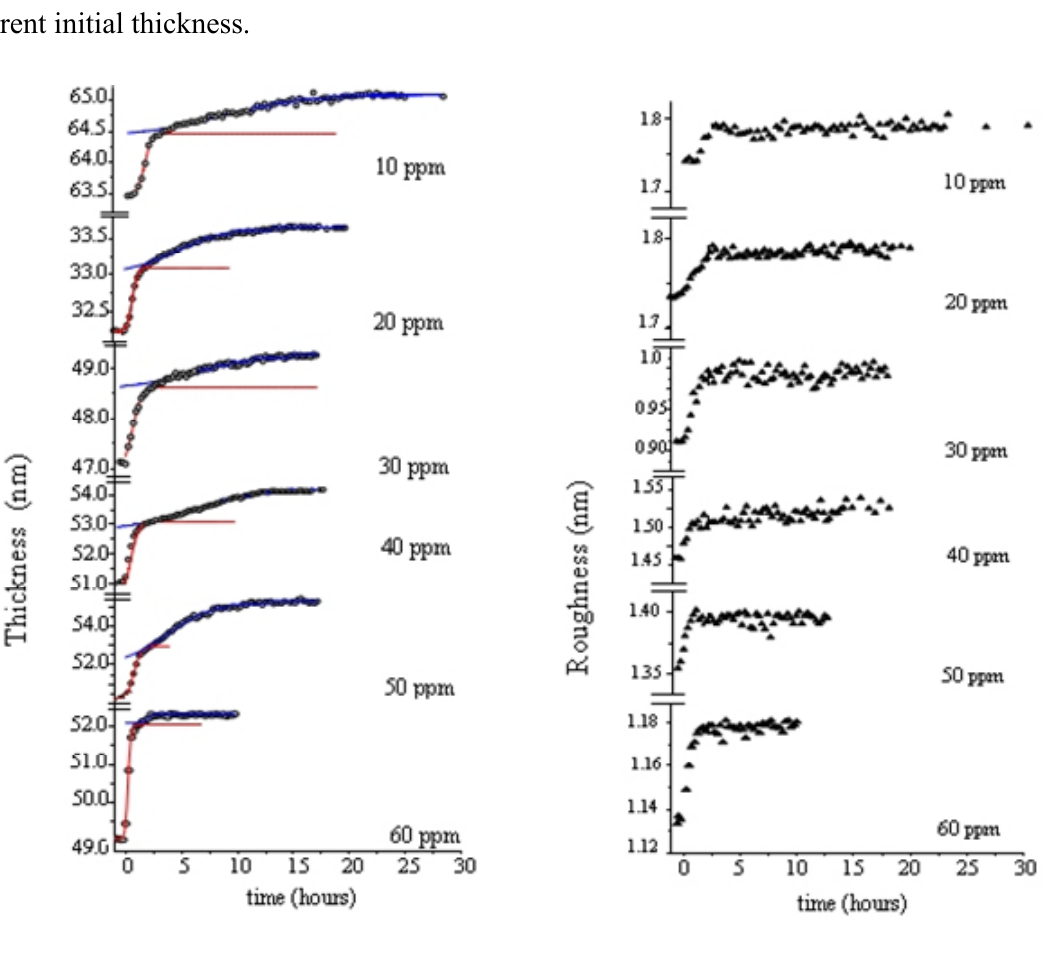
films, evaporated on silicon substrates, of 2